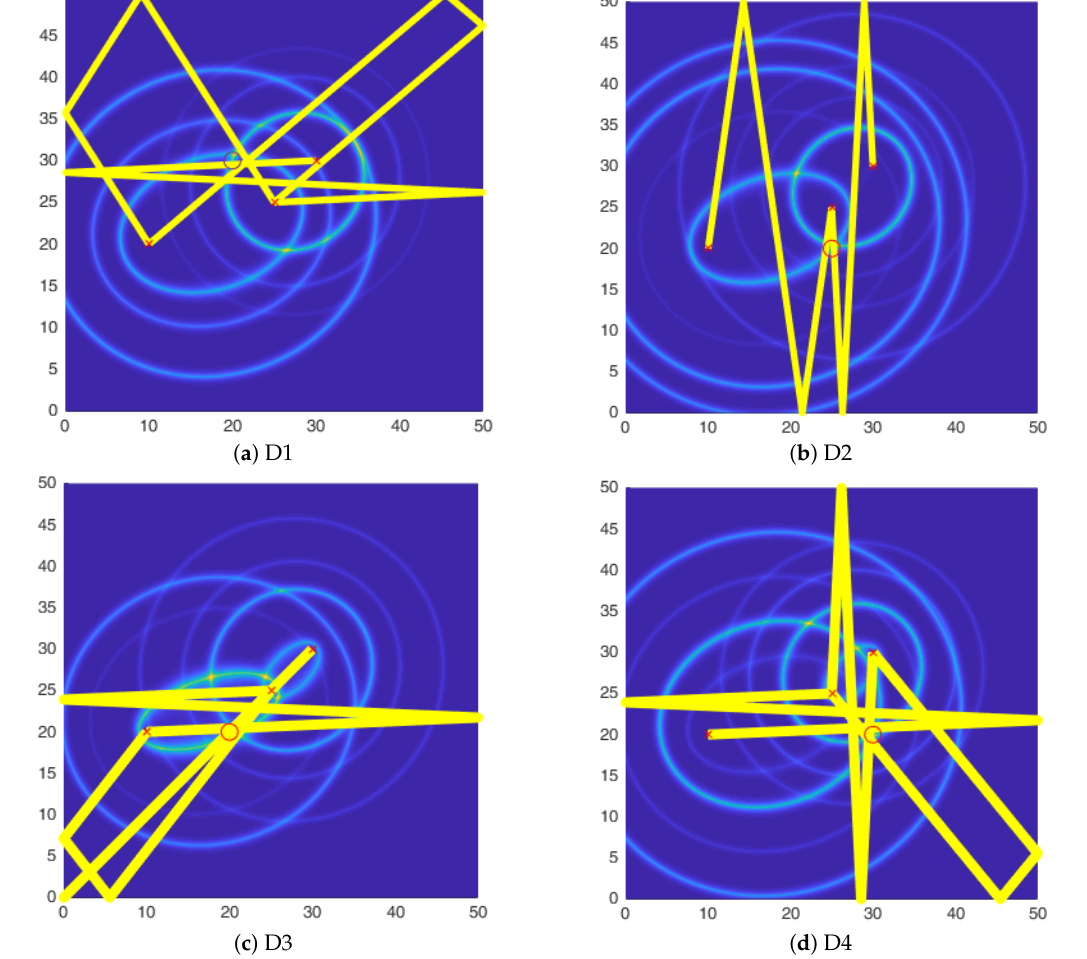
Figure 16. Damage localization using two-step